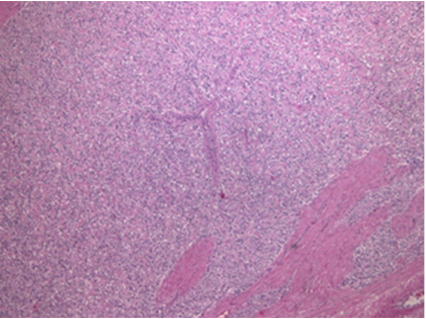
Figure 3: Endometrioid adenocarcinoma of the ovary, moderately di ff erentiated, showing aspects that suggest an endometriosis origin.